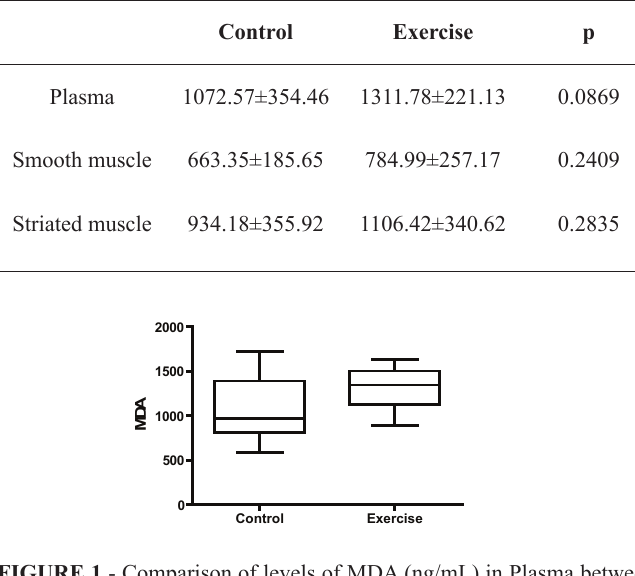
FIGURE 1 - Comparison of levels of MDA (ng/mL) in Plasma between groups (Student t test; p=0.0869).